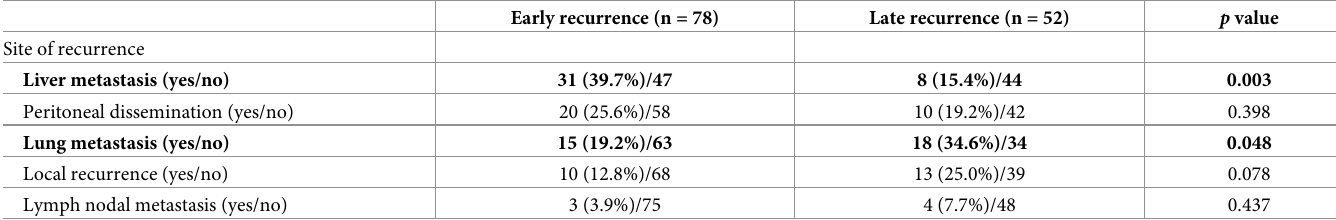
Table 1. Comparison of the recurrence form between early recurrence and late